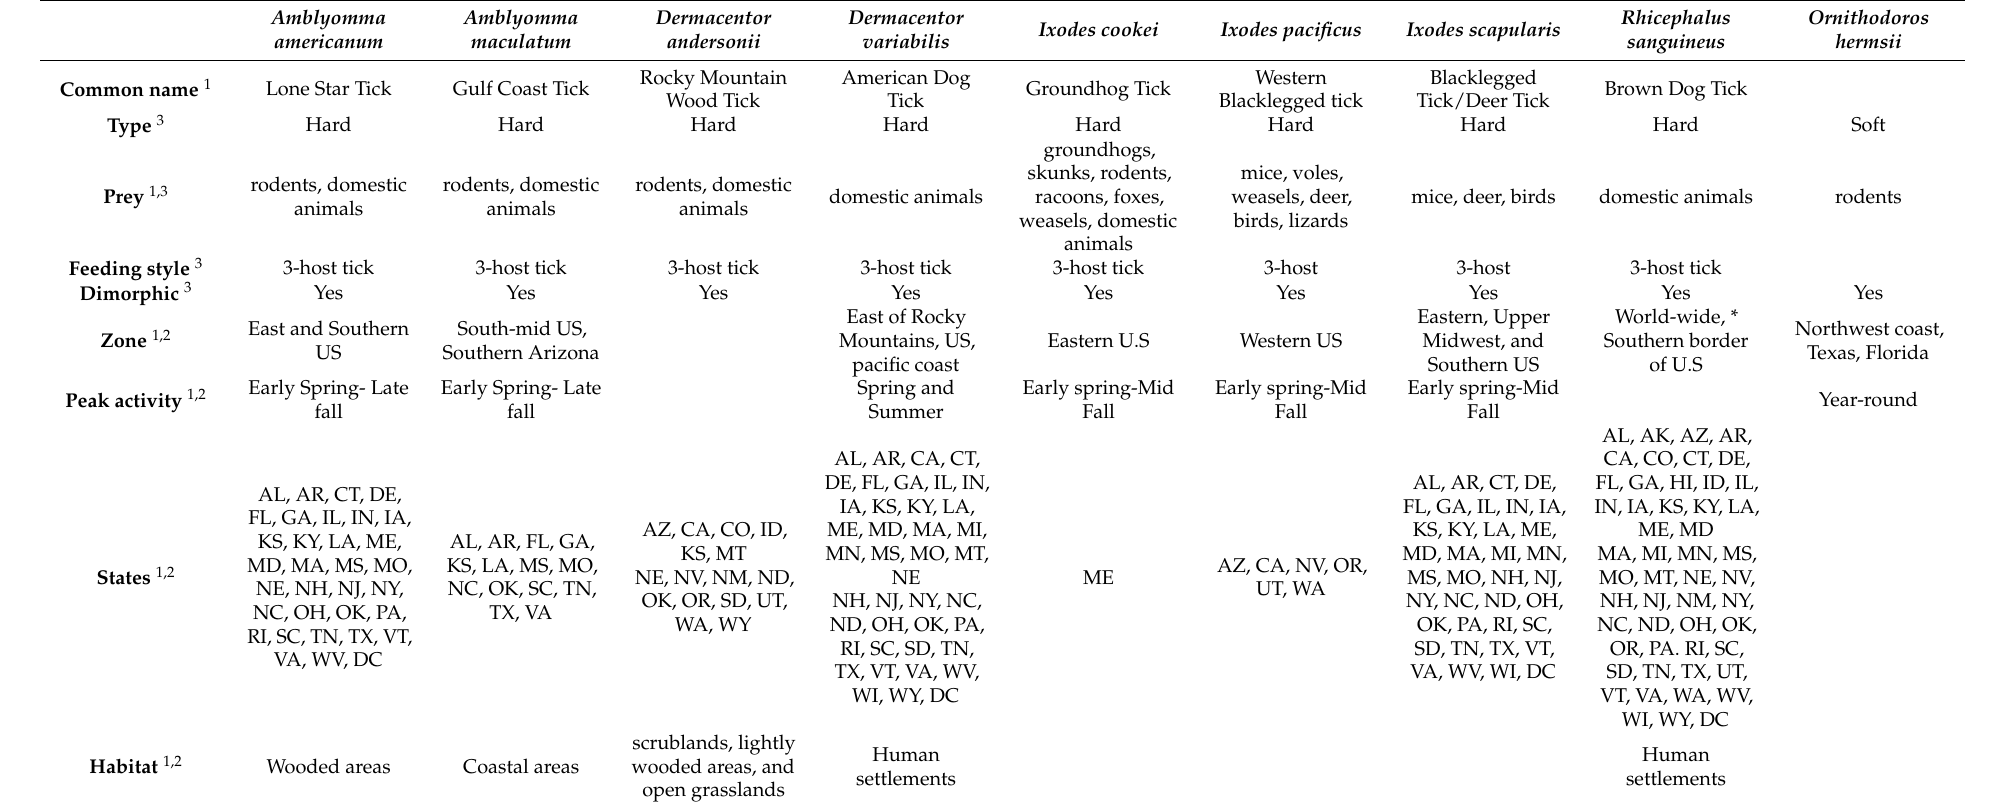
Table 1. Leading anthropophilic ticks within the United